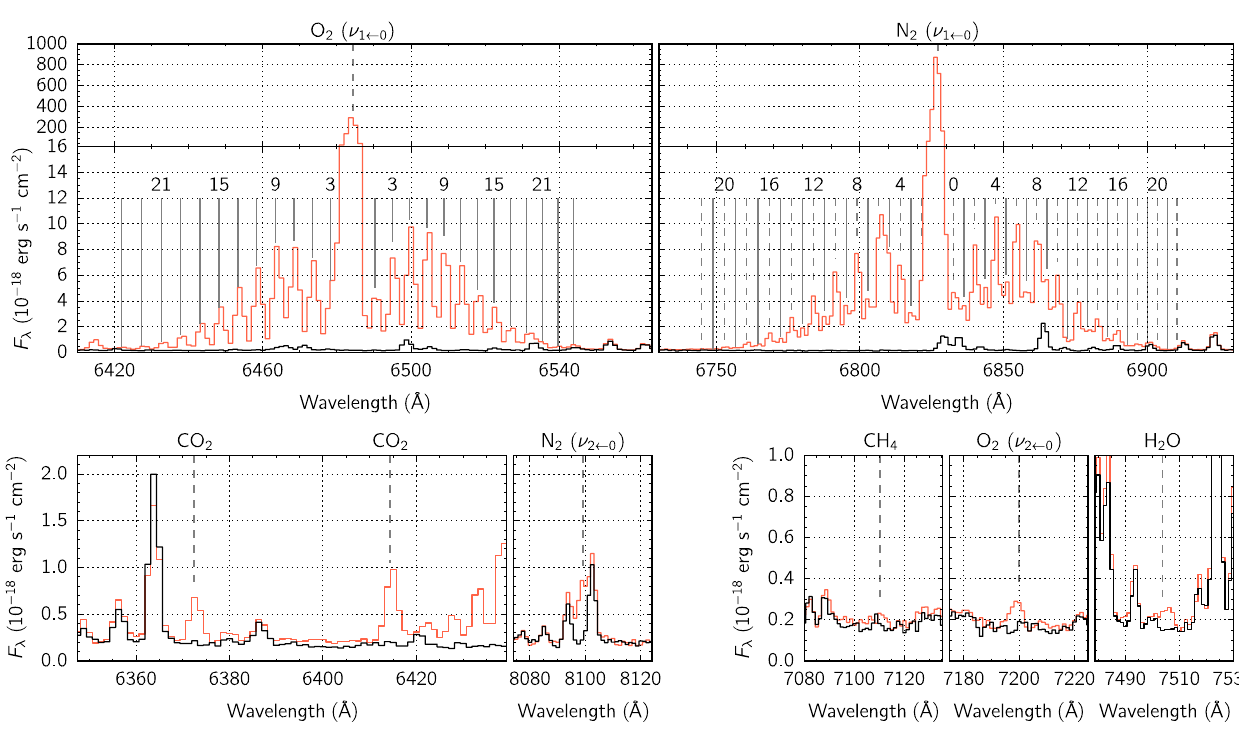
FIG. 6. Mean spectra from MUSE spaxels located within 20 arc sec from the center of the field, with the four LGS beam crossed over the field (red), and with no laser propagating (black). Each panel is centered on a Raman line of interest (which, unlike sky lines, have no counterpart in the reference spectrum in black). The rotational sidelines associated with the ν 1 ← 0 transition from the O 2 and N 2 molecules are detected up to J ¼ 23 . The fundamental Raman lines from CO 2 and H 2 O are clearly visible when the lasers are propagating in this configuration. The first overtone associated with the ν 2 ← 0 transition from O 2 and N 2 is also detected (the latter between two sky